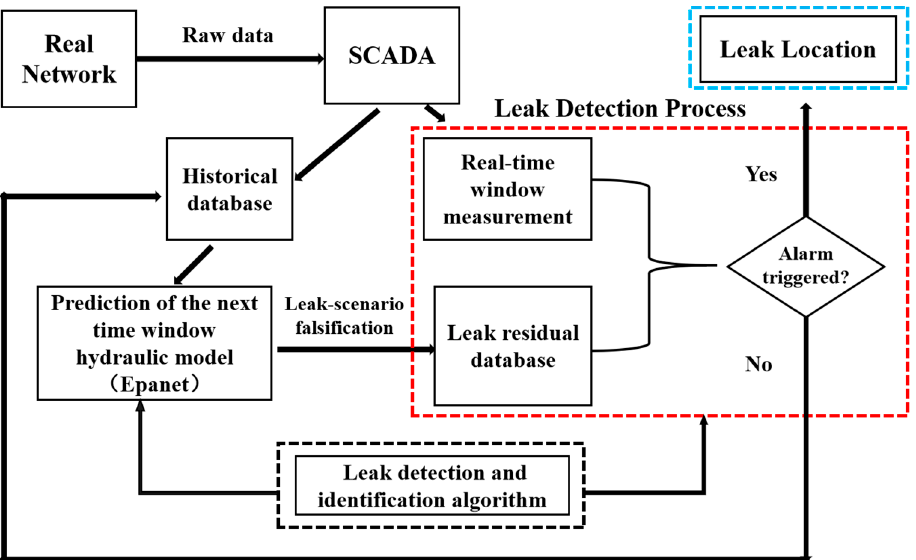
Figure 1. Framework of leak detection and localization methodology based on monitoring data and hydraulic model.